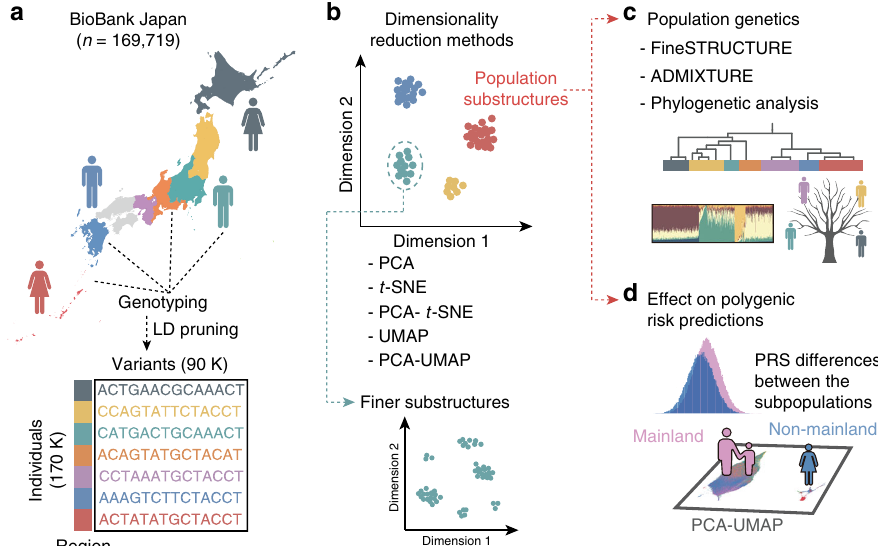
Fig. 1 Overview of this study. a Japanese individuals from seven major regions of Japan were genotyped. Phased and imputed genotypes were linkage disequilibrium (LD)-pruned and formatted as an input for dimensionality reduction methods. b We applied fi ve dimensionality reduction methods to the genotype. We further applied PCA – UMAP to the subpopulations in an attempt to identify even fi ner substructures. c We performed fi neSTRUCTURE, ADMIXTURE, and phylogenetic analyses in each subpopulation identi fi ed in b . d We investigated how the identi fi ed subpopulations affected polygenic risk predictions in a phenome-wide